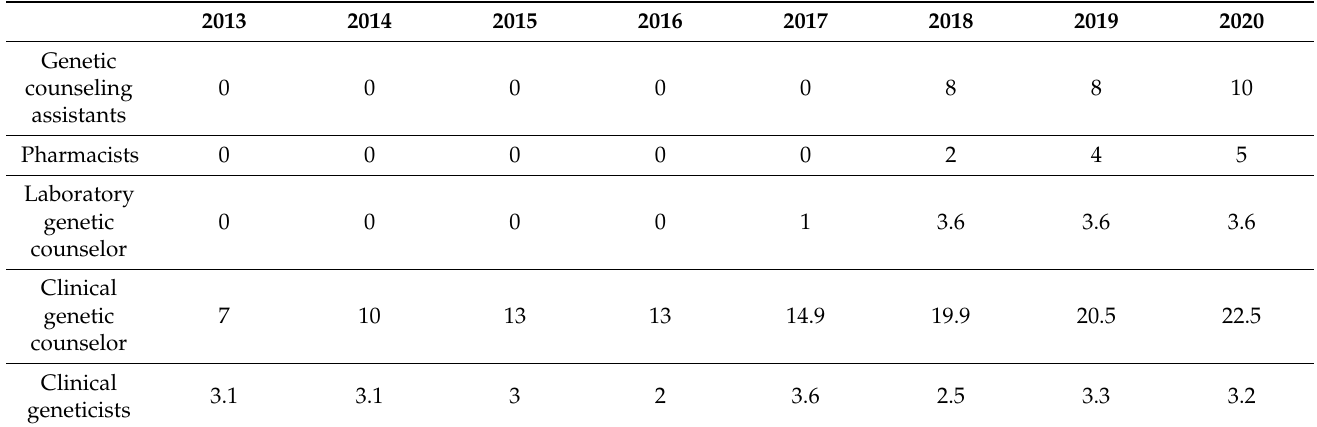
Table 1. Provider and staff changes over time in FTE for the precision medicine